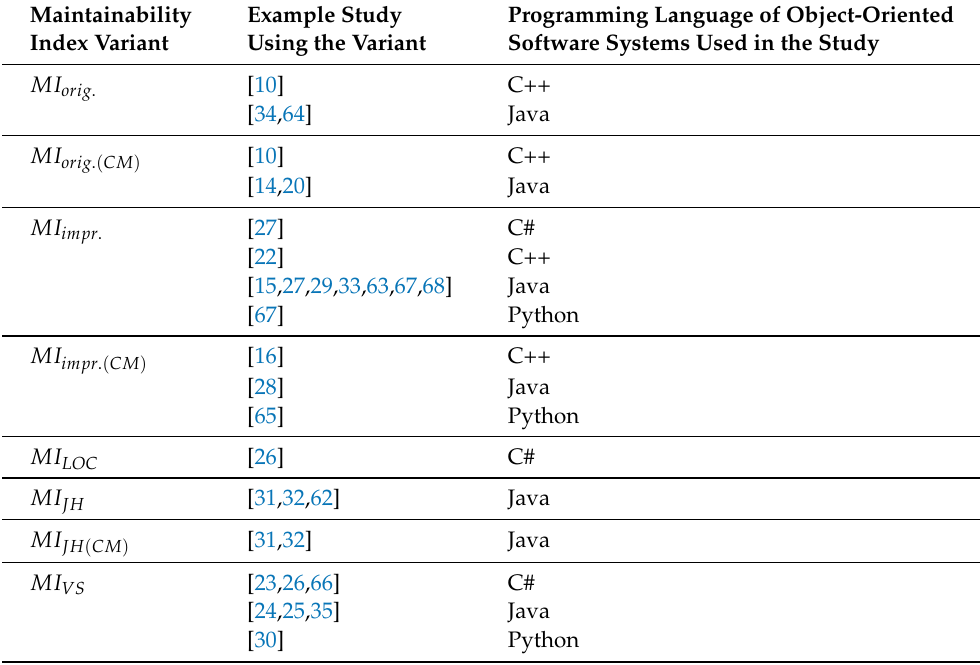
Table 2. Overview of studies using different Index